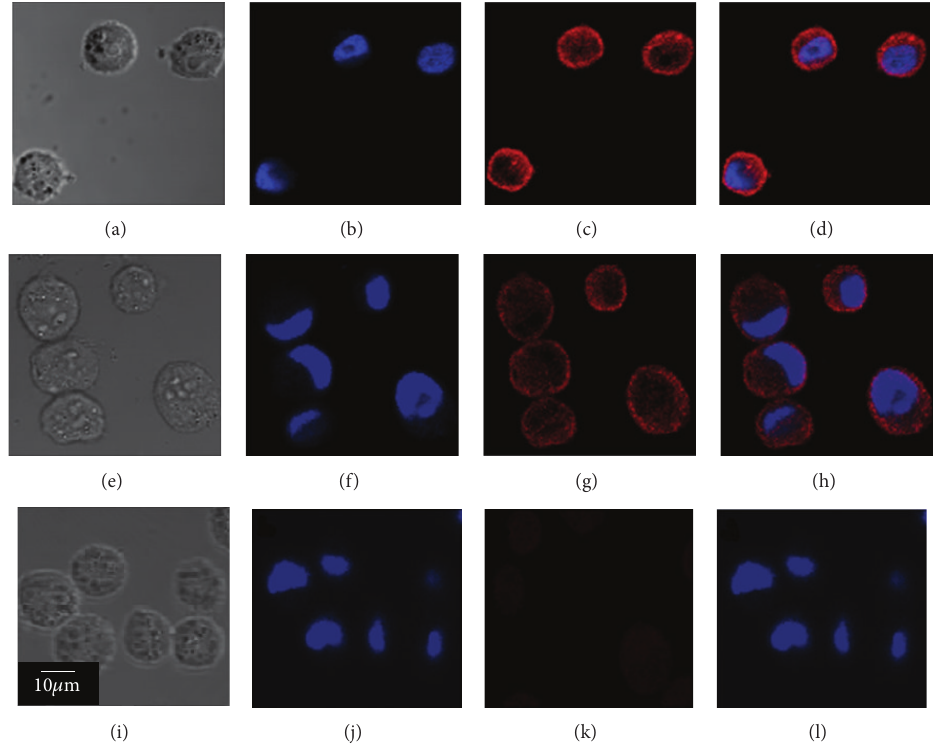
Figure 4: Subcellular localization of SP2 detected using Cy3-labeled goat anti-rabbit IgG and DAPI. ((a), (e), and (i)) Cells at the transmission light; ((b), (f), and (j)) nucleolus dyed with DAPI; ((c), (g), and (k)) SP2 dyed with Cy-3; ((d), (h), and (l)) merged images; ((i), (j), (k), and (l)) negative control group, using control rabbit